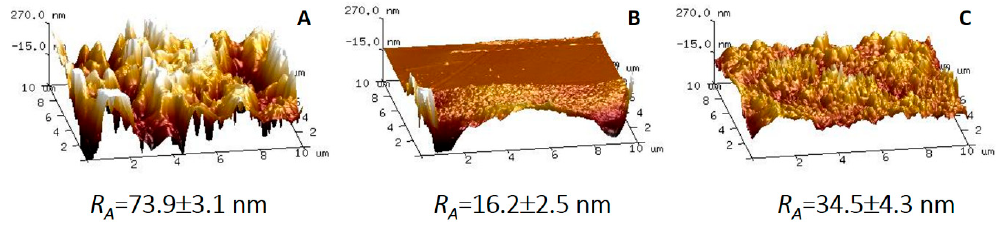
Figure 8. Surface topography and average values of R A of porous PA6 support ( A ), PVA / PA6 membrane ( B ), and PVA-NaY / PA6 membrane ( C ).